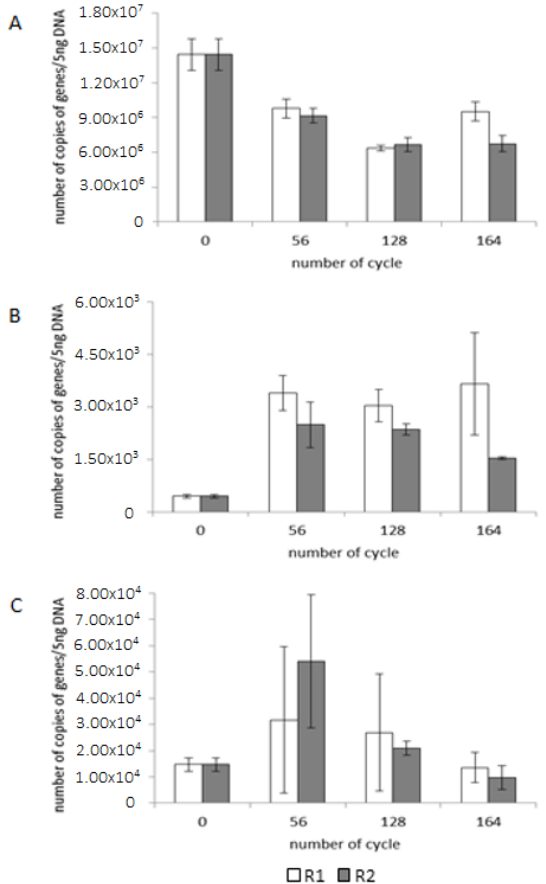
Figure 7. The absolute number of copies of ( A ) bacterial 16SrRNA , ( B ) amoA and ( C ) nosZ genes in the reactors.